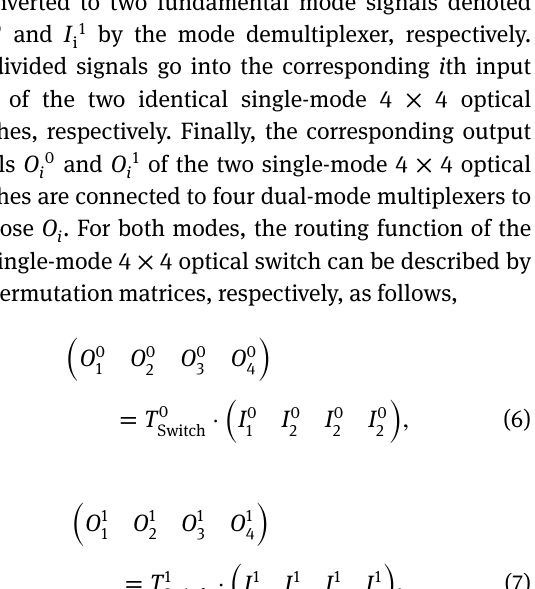
switchesarethenusedtoswitchopticalsignalswithineach spatial mode separately, and finally, the output signals are combined by mode multiplexers.